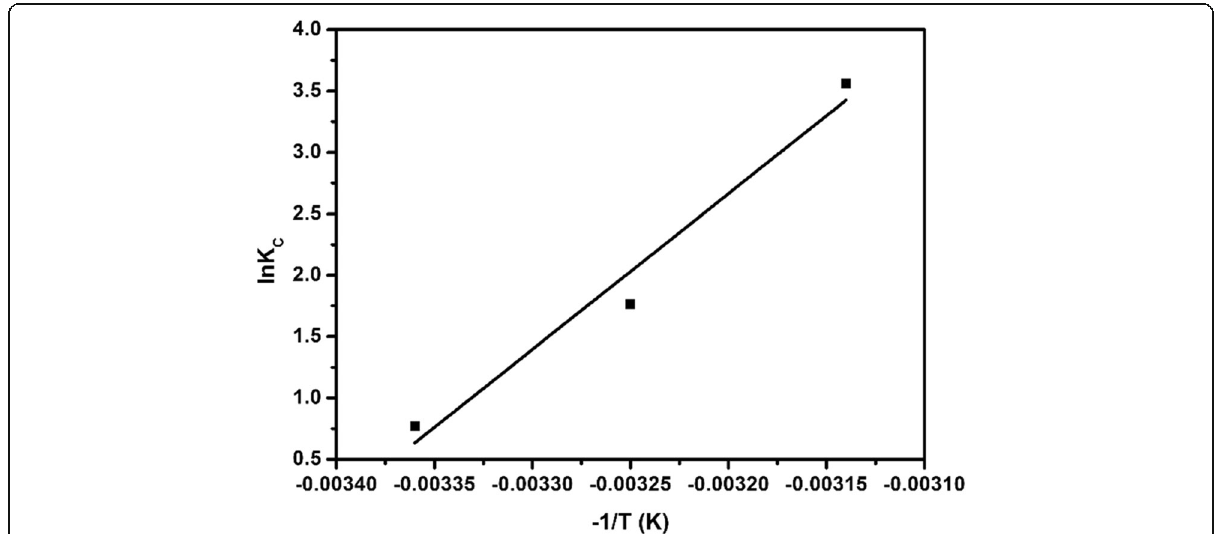
Fig. 14 Thermodynamic fit of copper sulfide adsorption EE2